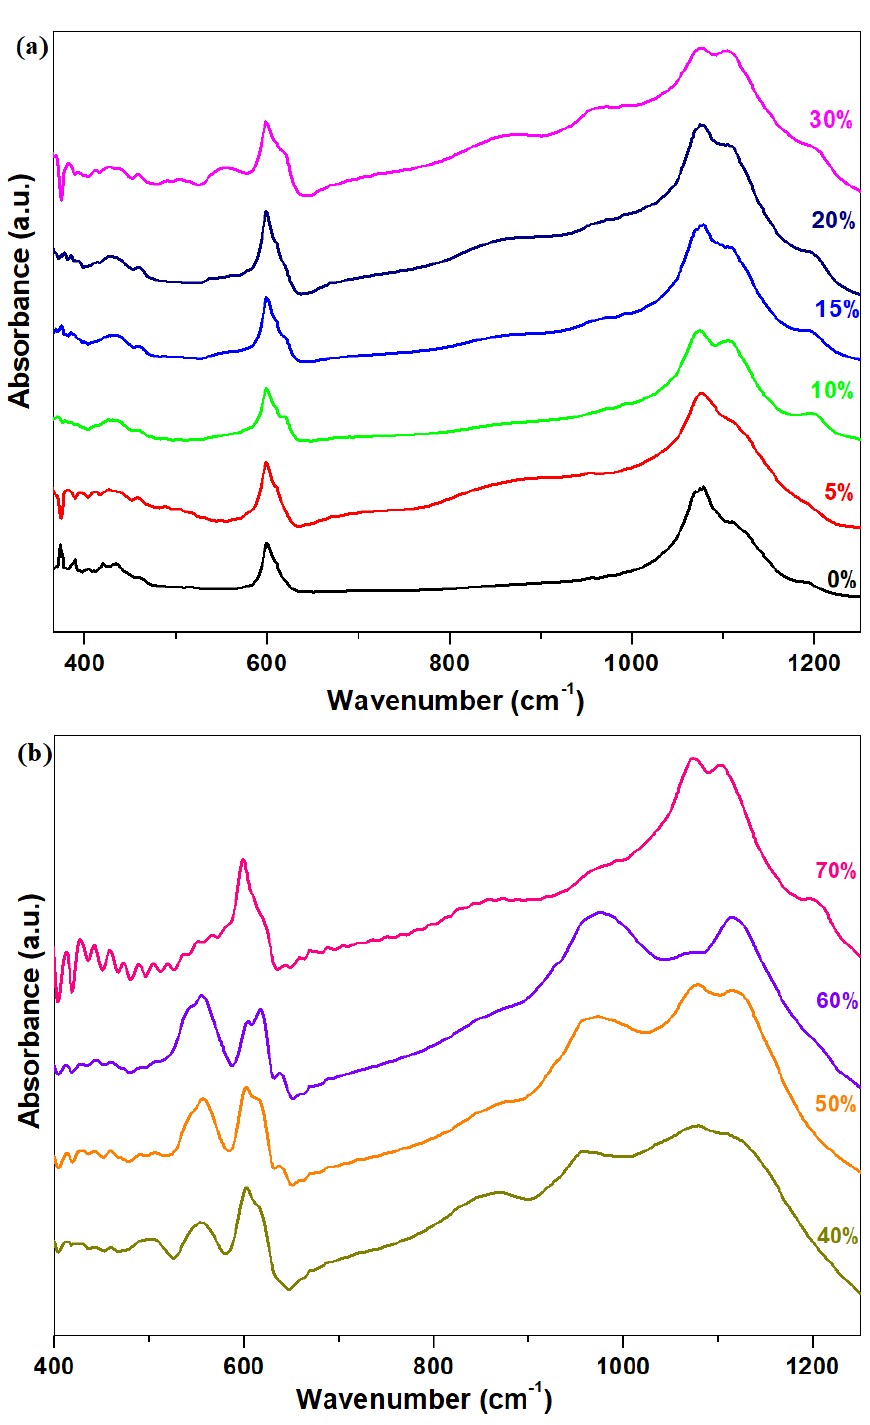
Figure 2. FTIR spectra of the vitreous system with xNaH 2 PO 4 · 5MnO 2 · (95 − x)[4PbO 2 · Pb] composition where ( a ) x = 0–30 mol% NaH 2 PO 4 , and ( b ) x = 20–70 mol% NaH 2 PO 4 . Examination of the IR data shows that some structural changes have occurred in the region between 500 and 1200 cm − 1 by the addition of varied dopant